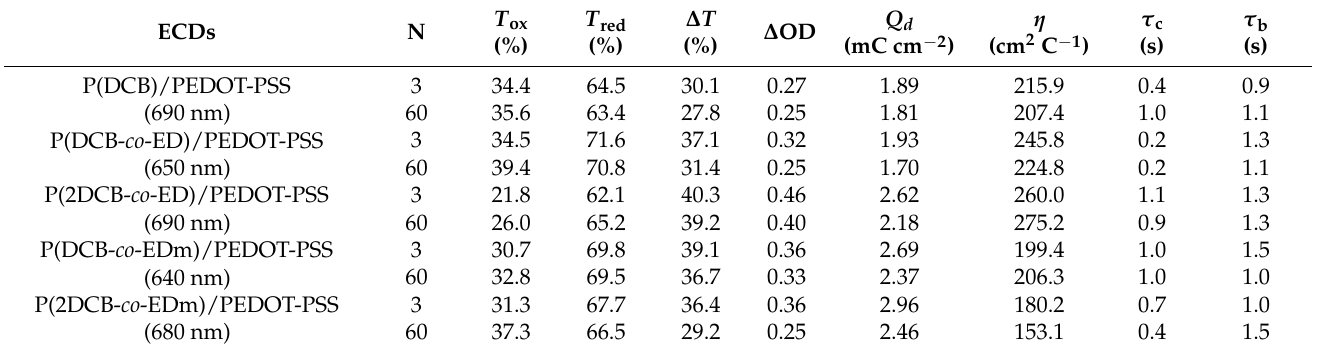
Table 6. Chromic switching parameters of